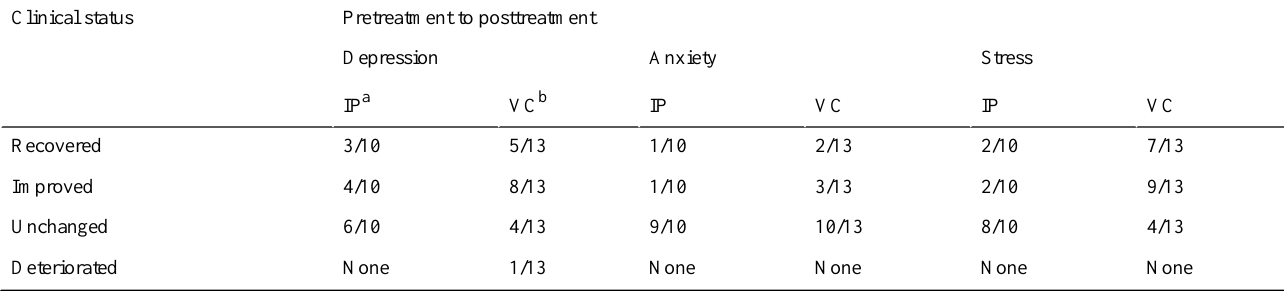
Table 4. Rates of clinical improvement from pre- to posttreatment for the DASS.